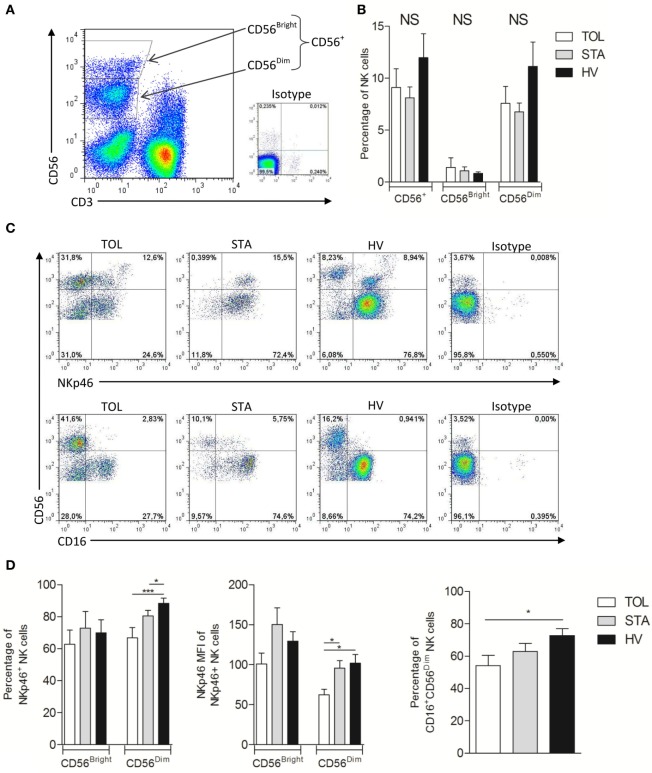
(A) Dotplot representation of the gates performed depending on CD3 and CD56 expression to divide natural killer (NK) cells into CD56Bright and CD56Dim subsets. Cells on the dotplot are lymphocytes gated regarding the morphology based on the SSC and FSC. Isotype controls are shown in the little dotplot. (B) Mean percentage with SEM of CD56+, CD56Bright, and CD56Dim NK cells in tolerant patient (TOL) (white bar) (n = 11), stable patient (STA) (gray bar) (n = 11), and healthy volunteer (HV) (black bar) (n = 15). (C) Representative dotplot of NKp46 (up) and CD16 (down) expression in NK cells in TOL (left), STA (middle), HV (right), and isotype controls (far right). (D) Mean percentage with SEM of NKp46+ NK cells (left) and mean of MFI with SEM of NKp46 (middle) among CD56Bright or CD56Dim NK cells and mean percentage with SEM of CD16+CD56Dim NK cells (right) in TOL (white bar) (n = 11), STA (gray bar) (n = 11), and HV (black bar) (n = 15). Significance was defined as *p < 0.05, **p < 0.01, ***p < 0.001, and ****p < 0.0001.